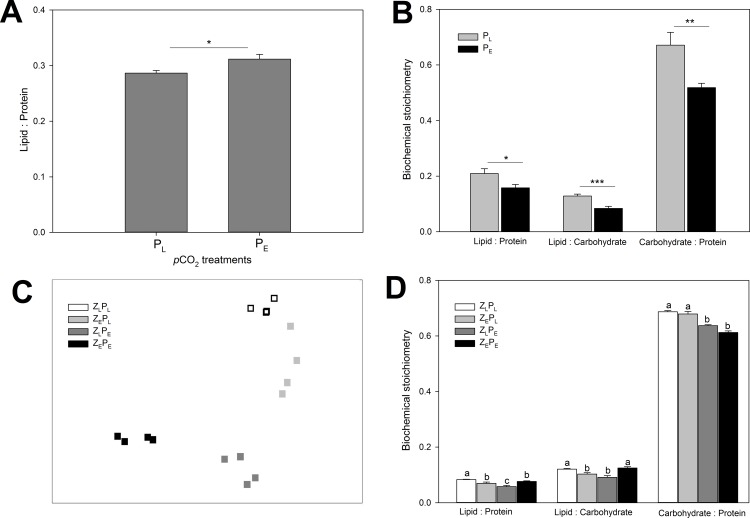
Biochemical stoichiometry of phytoplankton prey (A, B) and adult predator copepods (C, D) upon exposure to 4 different OA treatments.
A: The lipid: protein ratio of C. muelleri reared at ambient (PL) and elevated (PE) pCO2 levels. B: The lipid: protein, lipid: carbohydrate and protein: carbohydrate ratio of I. galbana reared at ambient and elevated pCO2 levels. Stars denote significance differences between the 2 treatments: *** = p < 0.001, ** = p < 0.01 and * = p < 0.05. C: Multi-dimensional ordinal scale (nMDS) plot representing the ordinal distance between the biochemical stoichiometry of A. tonsa adult populations exposed to 4 different pCO2 treatments for one-life cycle (ZLPL = both plankton prey and copepod predators reared under ambient pCO2 levels, ZEPL: prey reared under ambient pCO2 levels and predators reared under elevated levels, ZLPE: prey reared under elevated pCO2 levels and predators reared under ambient levels, and ZEPE: both prey and predator reared under elevated pCO2 levels). D: The variation in biochemical ratios across the four pCO2 treatments in adult Acartia tonsa. Letters denote significant difference between the 4 treatments within each group (biochemical ratio). Columns that do not share the same letter are significantly different from one another. The integrated band ratios assigned for each biochemical group are detailed in S1 Table. Corresponding pCO2 treatment concentrations are detailed in S2 Table. Values are average ± 1SE across all graphs.